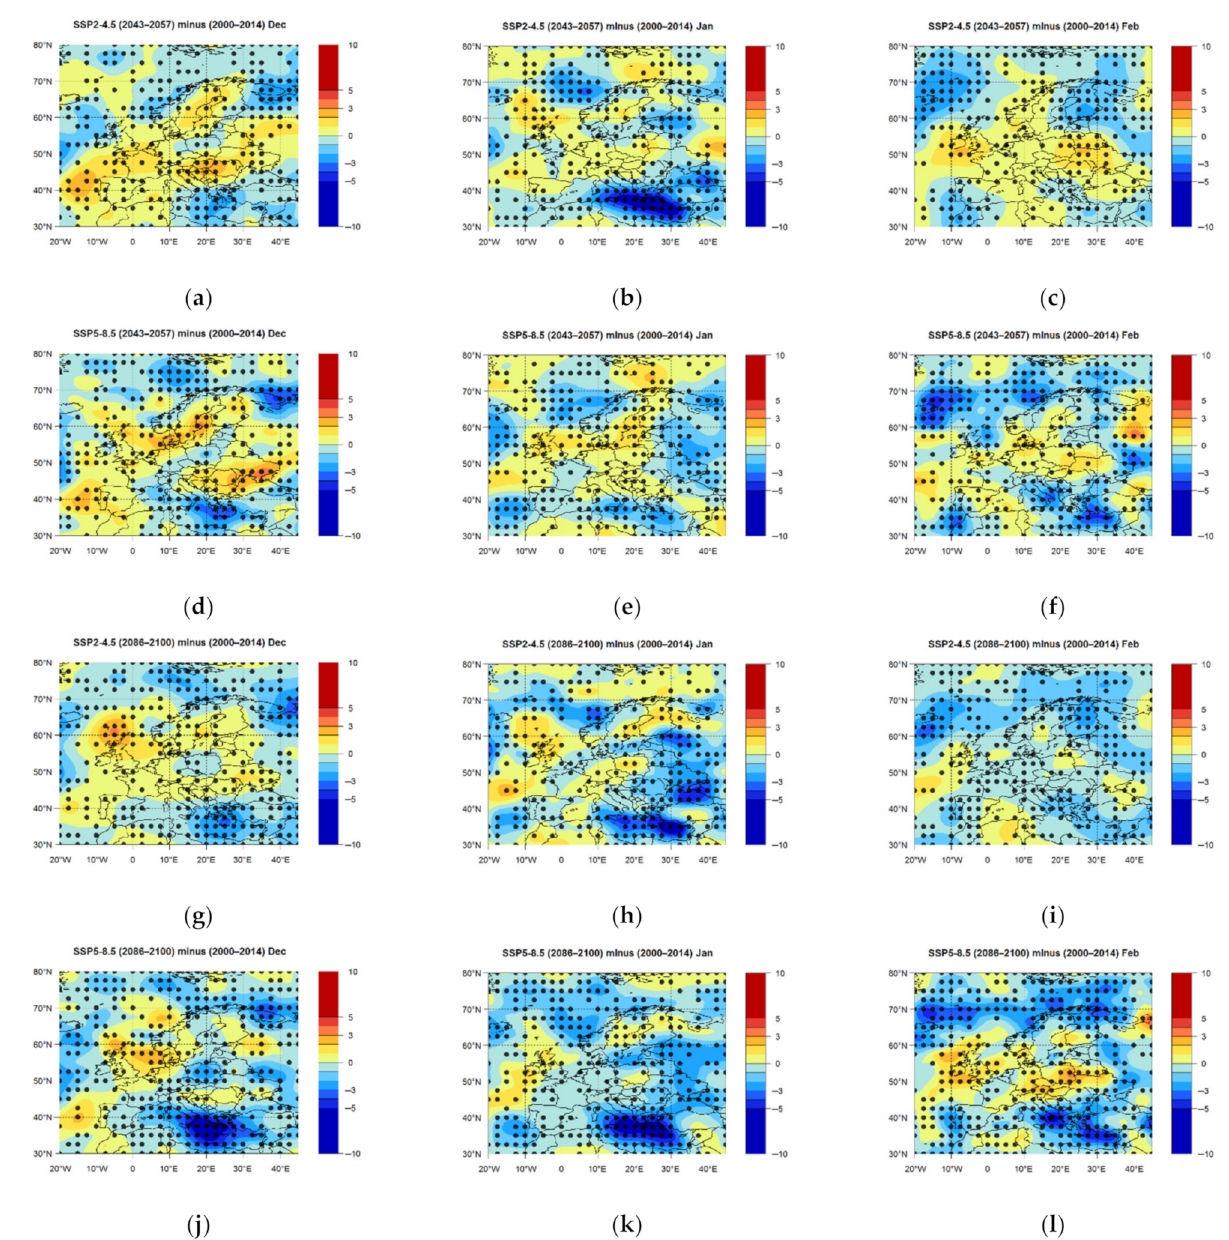
Figure 6. Absolute anomalies of the frequency of cyclones (difference in totals for 15 months) relative to the recent historical period (from 2000 to 2014) at the beginning of the century in December (left column), January (central column) and February (right column): ( a – f ) at the middle of the 21st century; ( g – l ) at the end of the 21st century; ( a – c , g – i ) under the SSP2-4.5 scenario; and ( d – f , j – l